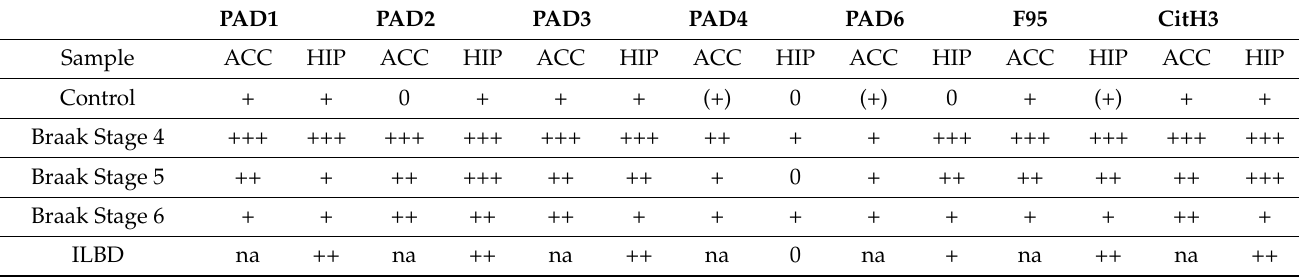
Table 1. Summary of immunohistochemical detection of PAD isozymes, histone H3 deimination (CitH3) and pan-deimination (F95) in anterior cingulate cortex (ACC) and hippocampus (HIP) of post-mortem human PD brains at Braak stages 4-6 and incidental Lewy body disease (ILBD). Scoring is shown as 0,+,++ and +++, respectively, based on the scoring index in Supplementary Figure S1. 0 indicates negligible staining; + low positive, ++ medium positive, and +++ strong positive staining; na is indicated for ACC as ILBD was assessed in hippocampus